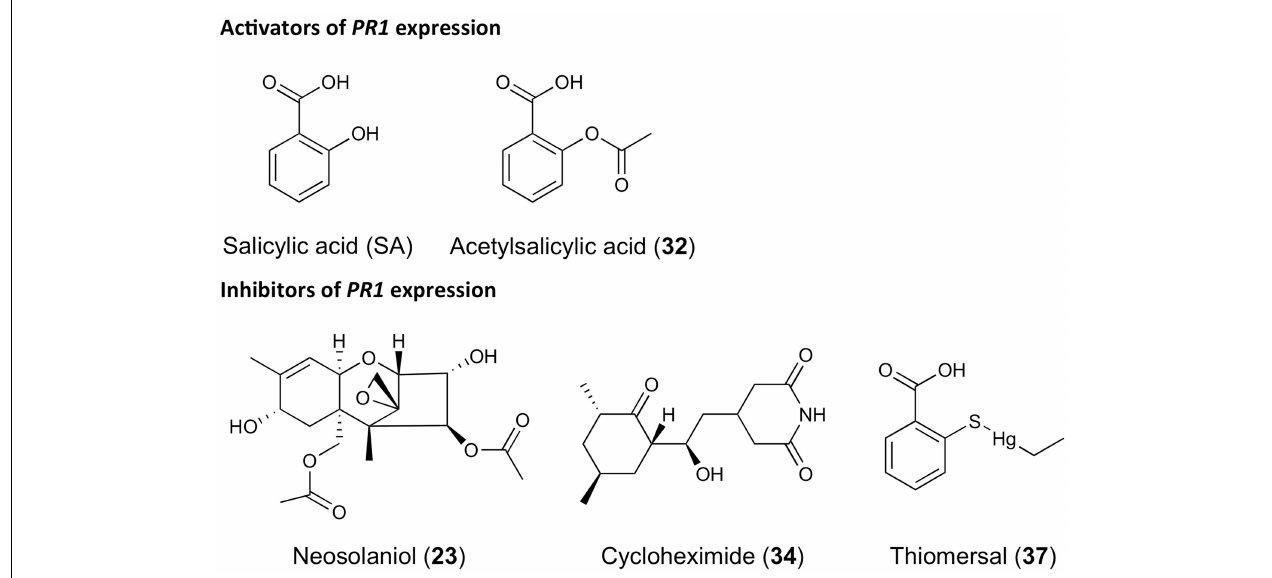
FIGURE 9 | Structures of bioactive compounds modulating PR1 gene expression. Examples refer to compounds mentioned in this paper that were identified in the small pilot screen described.